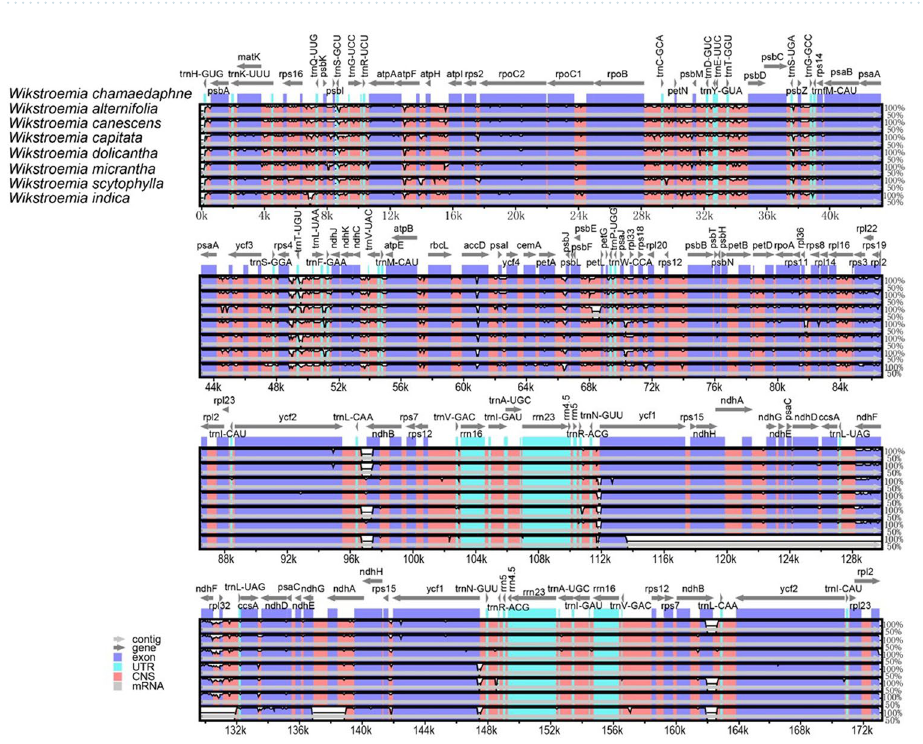
Figure 4. Complete plastome comparison of eight species of Wikstroemia using the plastome of W. chamaedaphne as